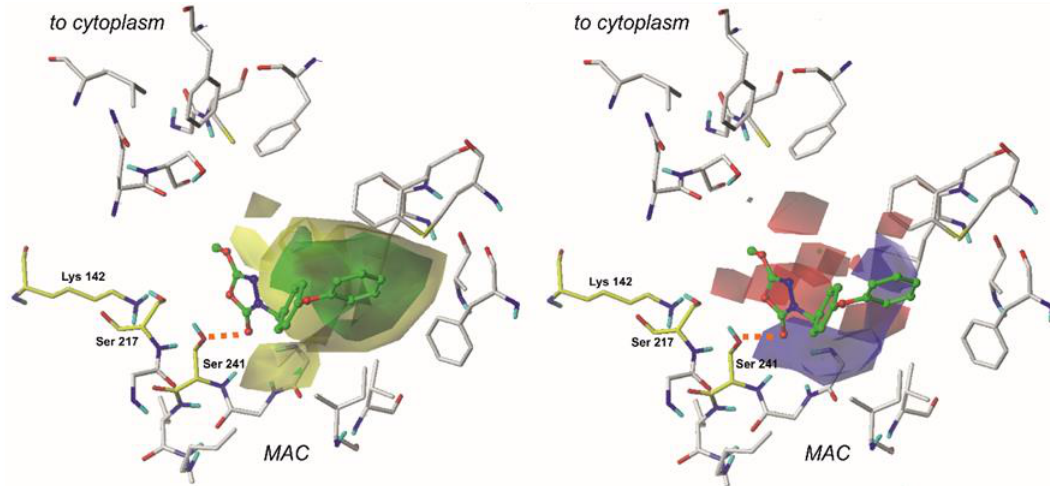
Figure 4. Comparative Molecular Field Analysis (CoMFA) electrostatic (right) and steric (left) fields projected on the 3D structure of the fatty acid amide hydrolase in complex with the most active compound ( 1 ). Fields are drawn with 70/30 proportions. Ligands are depicted as sticks and balls with green carbon atoms. Protein is shown as with gray carbon atoms. Catalytic residues are presented as sticks and are colored using yellow carbon atoms. A bond formed between a ligand and an enzyme is depicted as an orange dashed line. Non-polar hydrogens are omitted for clarity.